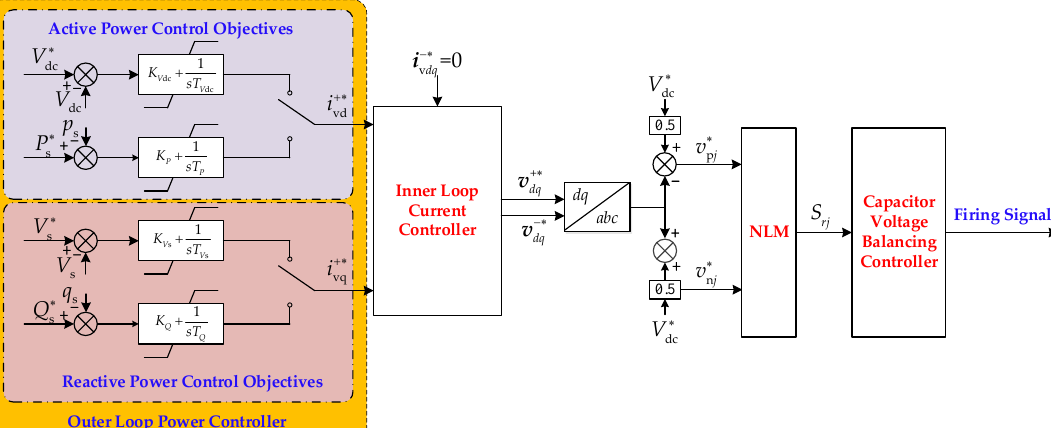
Figure 10. The control schematic of the MMC-HVDC system.